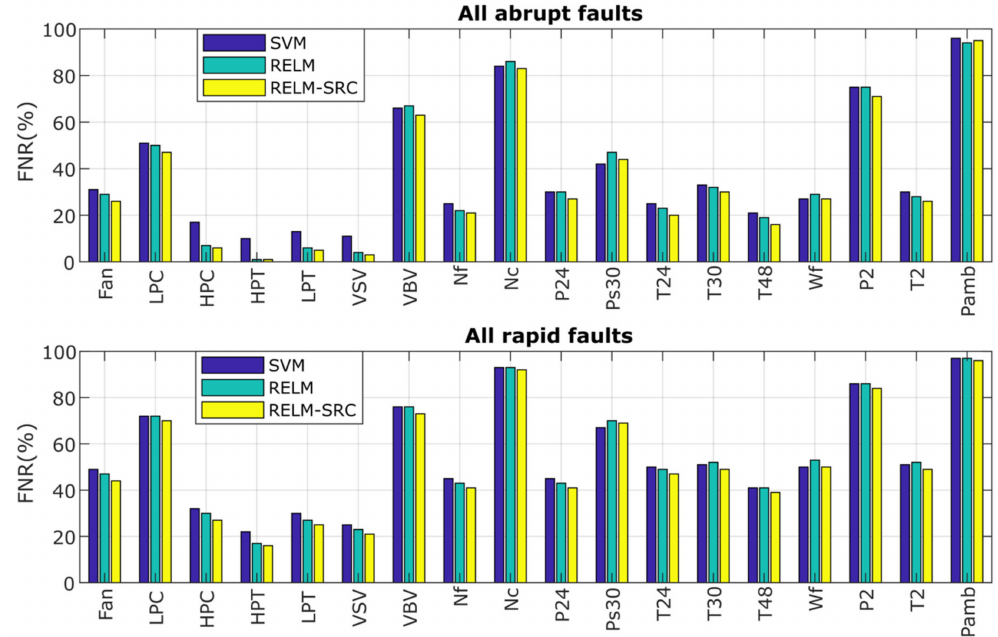
Figure 9. False-negative rate (omitted faults) of three techniques for abrupt and rapid faults (Stage 4). Continuing with the analysis of Table 11, MCR is computed as TPR minus CCR